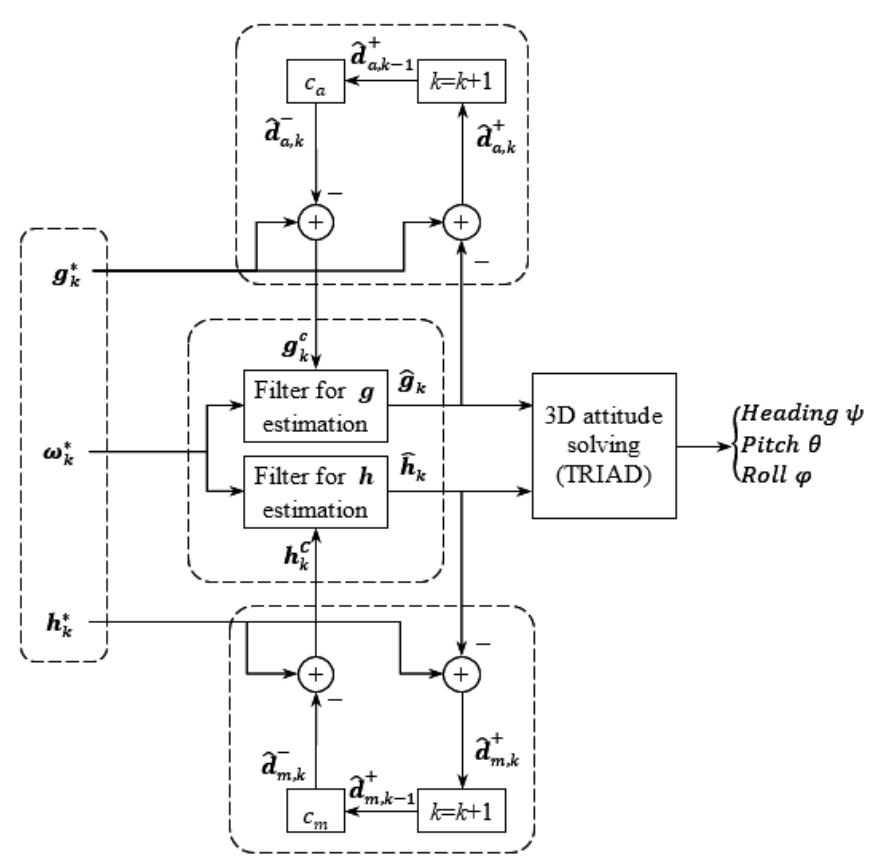
Figure 2. Block diagram of vector ‐ based parallel attitude filter with external disturbances rejection.